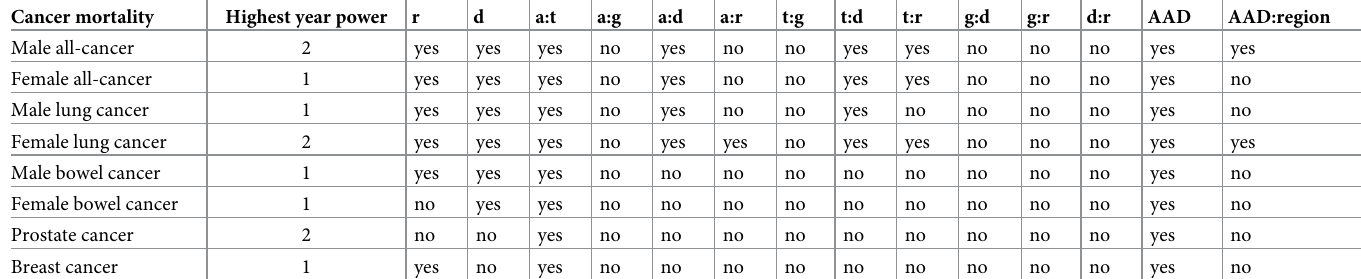
Table 3. Variables included in the best fitted models for different types of cancer mortality; main variables are denoted as age (a), year (t), gender (g), region (r), deprivation (d), average age-at-diagnosis (AAD), with corresponding interactions shown as, e.g., a:t. Cancer